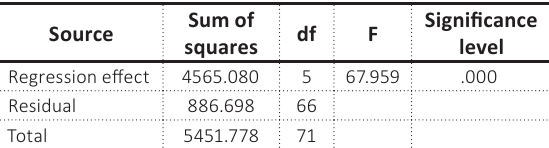
Table 6. Variance of multiple regression of job satisfaction